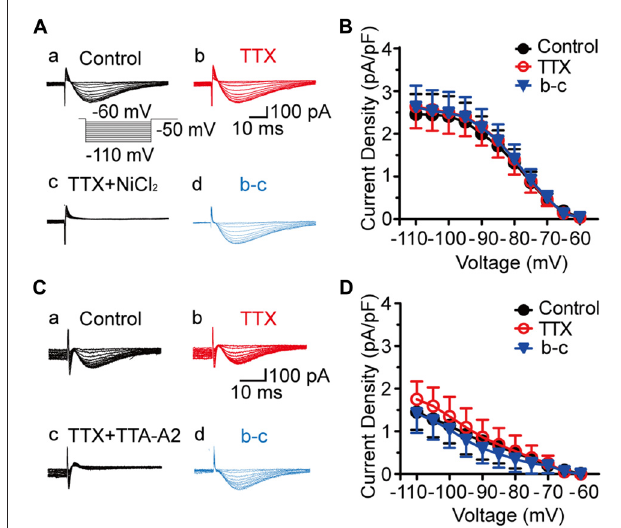
FIGURE 1 | Isolation of T-type current in substantia gelatinosa (SG) neurons from the rat transverse spinal cord slices. (A) Representative families of current traces in control (Aa) , with 0.5 µ M tetrodotoxin (TTX; Ab ), 1 mM NiCl 2 (Ac) , and that of the digital subtraction of (Ab–Ad) . The inset shows the voltage-clamp protocol. (B) Plots of T-type current density against the test potentials in various groups showing in Aa , Ab , and Ad ( n = 19 cells in four rats). (C) Representative families of current traces in control (Ca) , with 0.5 µ M TTX (Cb) , 40 µ M TTA-A2 (Cc) , and that of the digital subtraction of (Cb–Cd) . (D) Plots of T-type current density against the membrane potentials in various groups showing in Ca , Cb and Cd ( n = 7 cells in three